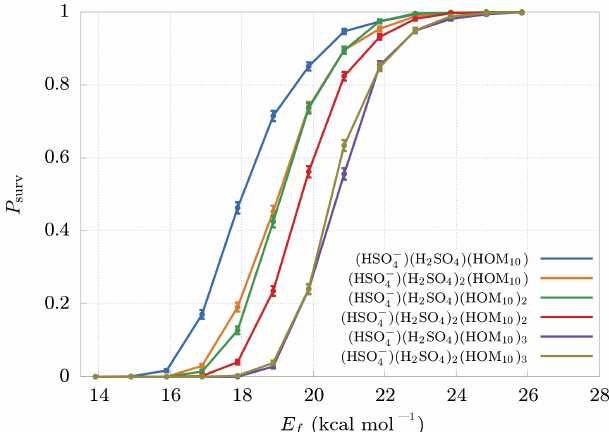
Figure 5. Survival probabilities P surv for different HOM clusters as a function of their decomposition energy E f . The error bars are relative only to statistical